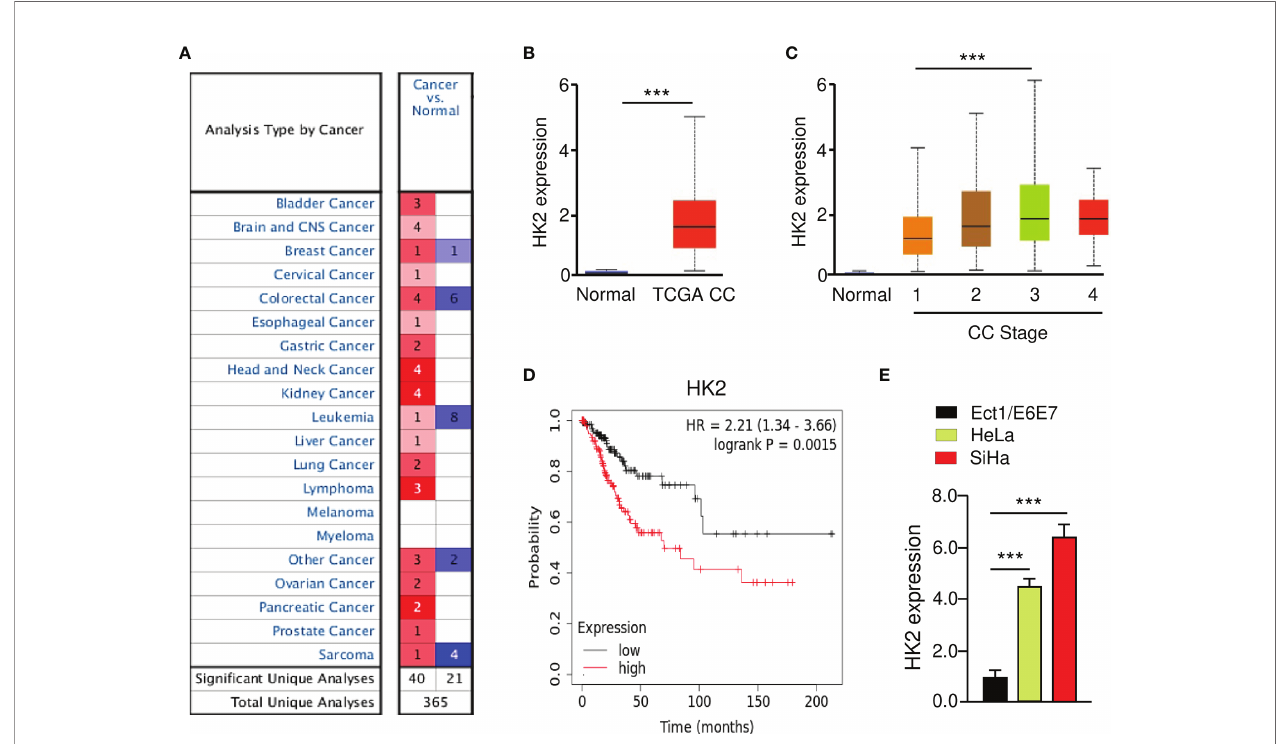
FIGURE 1 | Overexpression of HK2 Correlates with Poor Prognosis in CC Patients. (A) The expression of HK2 in different types of cancer (Oncomine database). (B) The levels of HK2 in TCGA CC and normal tissues were examined using the UALCAN database. (C) Correlation between HK2 expression and tumor stage in CC patients (UALCAN database). (D) The prognostic value of HK2 in CC patients (KM plotter database). (E) The qRT-PCR analysis of HK2 expression in CC cells and normal ectocervical cell line Ect1/E6E7. *** P <